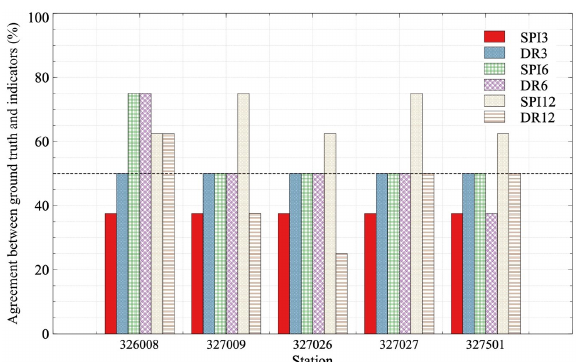
Fig. 4. Agreement between ground truth and drought indicators using SPI < 0 and DR ≤ 4 drought